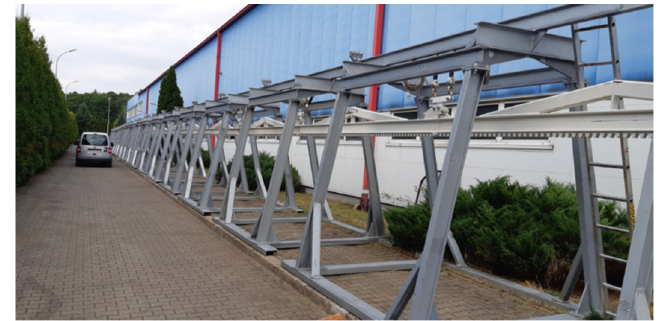
Figure 1. View of the test stand [2].